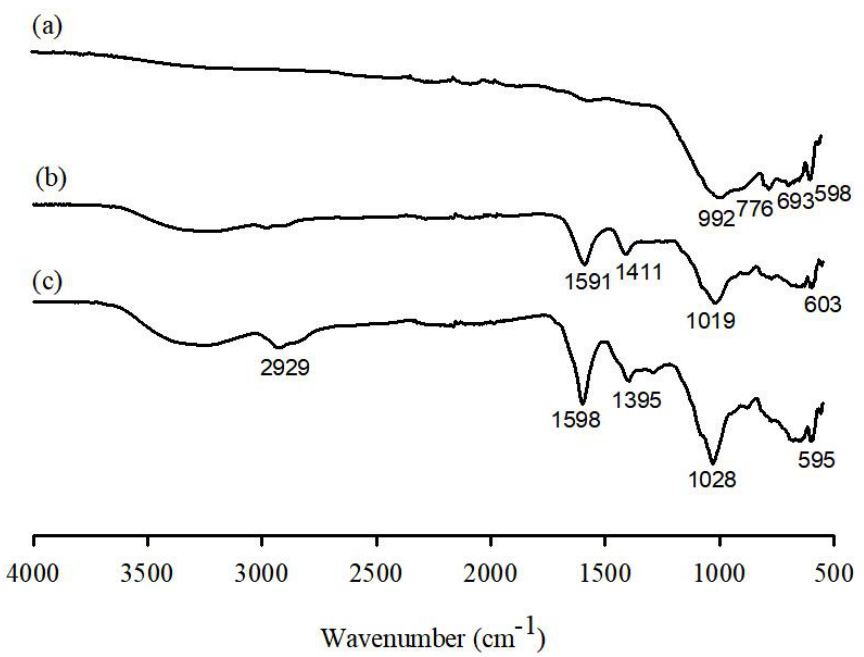
Figure 7. Fourier transform infrared spectroscopy measurements of WFD, WFD/SA bead and WFD/SA-PEI bead.